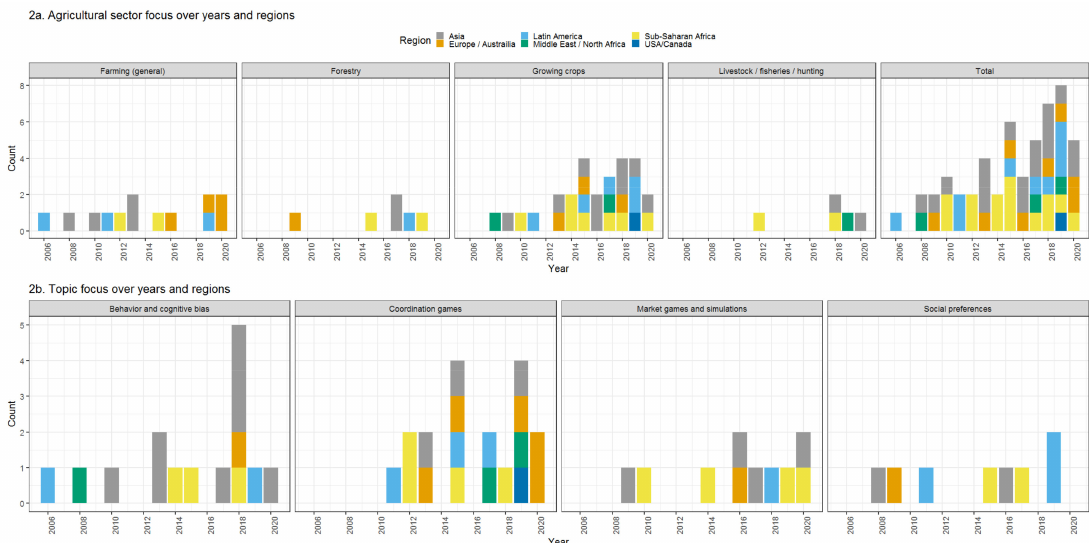
Figure 2. Domain and frequency of studies by the agricultural sector, topic and region. Games were more frequent in Asia, Sub-Saharan Africa, and Latin America, and mainly involved coordination and cooperation. Social preference games were specially oriented to measure trust, while behavioral and cognitive bias games focused on risk preferences and attitudes (Figures A1 and